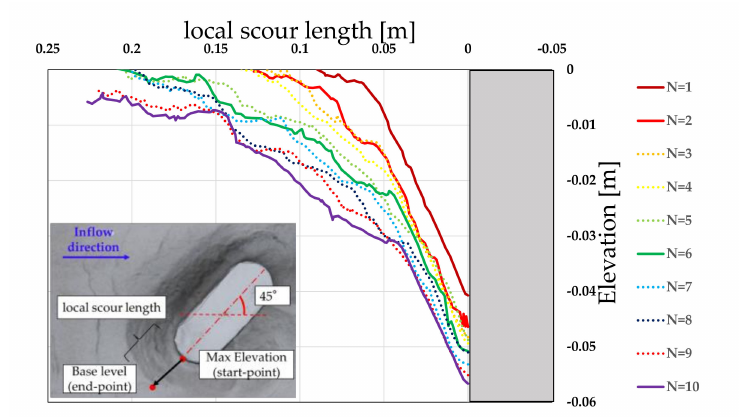
Figure 23. Cross-sectional view of local scour hole in Case 11 (point 1).